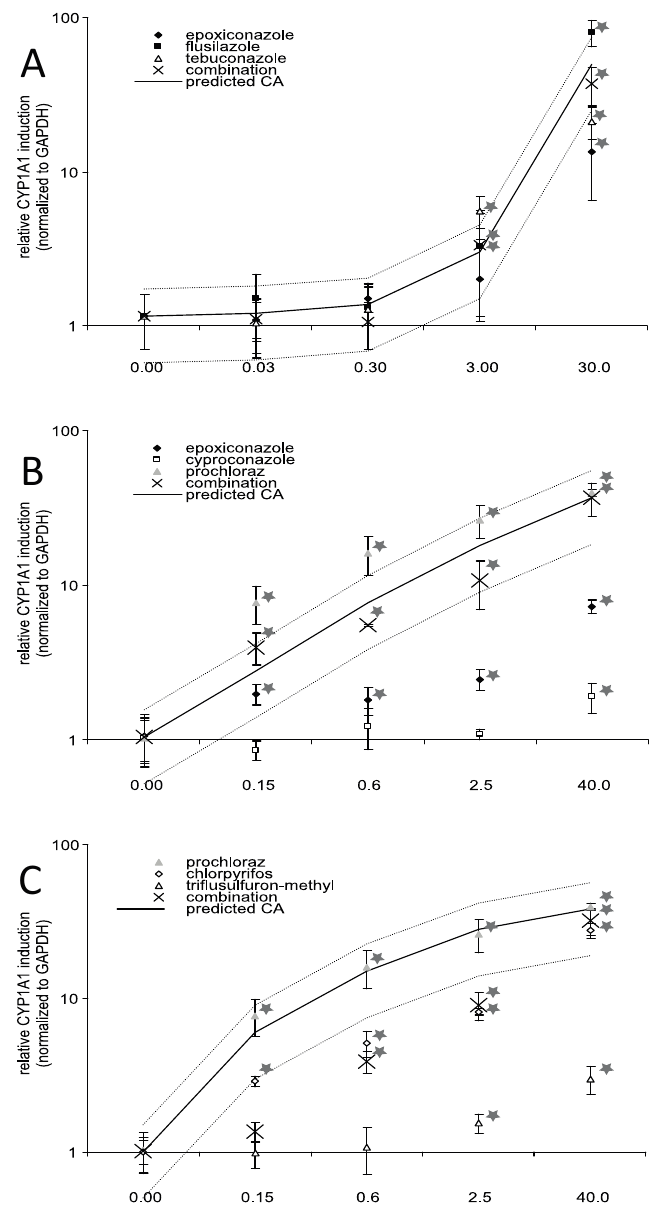
Figure 4. Influence of substance treatment alone or in combination on CYP1A1 mRNA expression. Jeg-3 cells were grown in 6-well cell culture plates for 24 h. Thereafter, the cells were incubated with the substances in concentrations as indicated for 48 h individually and in combination: ( A ) flusilazole, epoxiconazole and tebuconazole, ( B ) epoxiconazole, cyproconazole and prochloraz, ( C ) prochloraz, chlorpyrifos, triflusulfuron-methyl. Finally, the RNA was isolated and reverse transcription performed as described. The data represent the mean ± SD for three independent experiments. Concentration values given for combination treatments reflect total concentrations of all three components. Predicted additivity (CA) indicates the calculated combination effect when additivity is assumed. The upper and the lower lines around the predicted CA indicate the MDR (model deviation ratio) based on the predicted CA. Concentrations are given in µM. * Indicates significance with p ≤